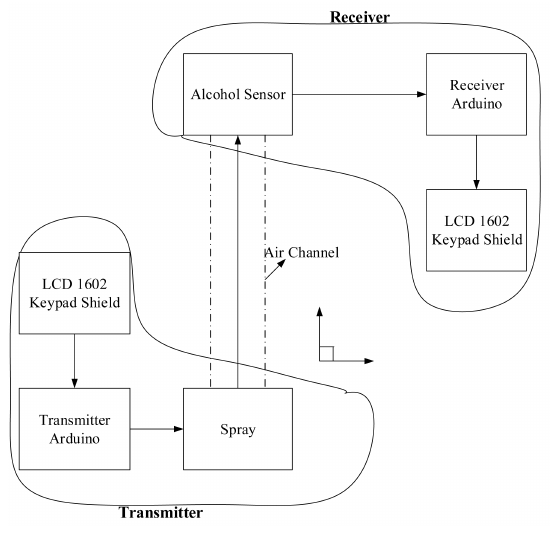
Figure 4. The craft (cid:12)gure of the test-bed The receiver is consist of MQ-3 alcohol sensor, the microcontroller and the LCD 1602 keypad shield. At (cid:12)rst, the MQ-3 alcohol sensor can produce a value from 0 to 1023 according to the concentration or the number of the alcohol molecules, then transmits the value to the receiver. Finally, the microcontroller at the receiver can demodulate the information from the alcohol sensor into "0" or "1", and show the decoded information to the LCD 1602